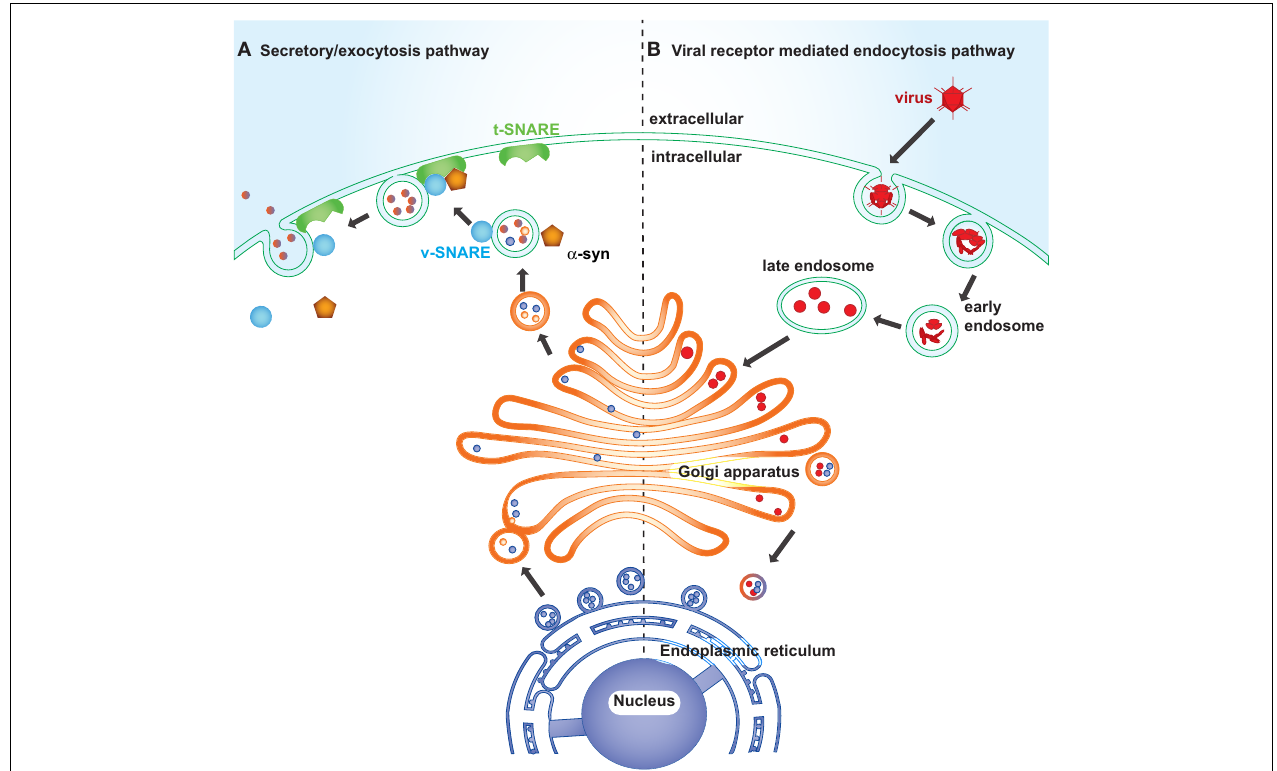
complex, thus to merge the vesicle membrane with the target membrane and evacuate neurotransmitters into the extracellular space.The vesicle releasing process is under the assistance of α -synuclein, CDCrel-1, and synaptotagmin. Right:Viruses enter host cells through endosomes. Late endosomes fuse with or convert to lysosomes to degrade its contents, or alternatively it forms budding vesicles that pass to the trans-Golgi region and translocate to the Golgi and endoplasmic reticulum.The endoplasmic reticulum is coated with ribosomes, which assemble the viral amino acids into viral